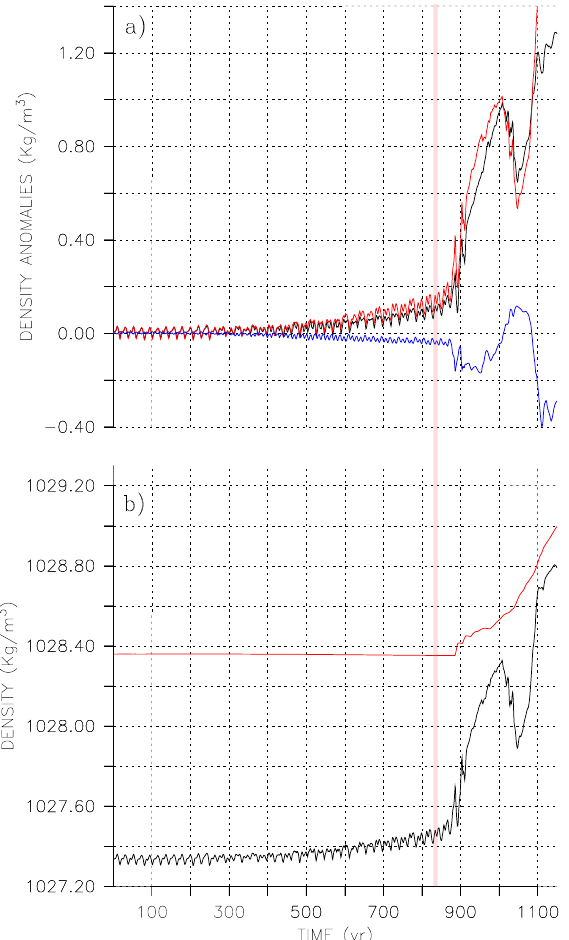
Fig. 4. (a) Surface anomalies with respect to the stadial state of density (black), together with salinity (red) and temperature (blue) contributions to density changes in kgm − 3 over the Nordic Seas area (67.5 ◦ N–75 ◦ N, 4 ◦ W–7.5 ◦ E; black box in Fig. 3a), assuming a linear equation of state for density for the CO 2 -only experiment; (b) density evolution in kgm − 3 over the same region at the surface (0–87.5m; black line) and depth (2800m; red line). The red shaded bar indicates the transition stage for the CO 2 -only